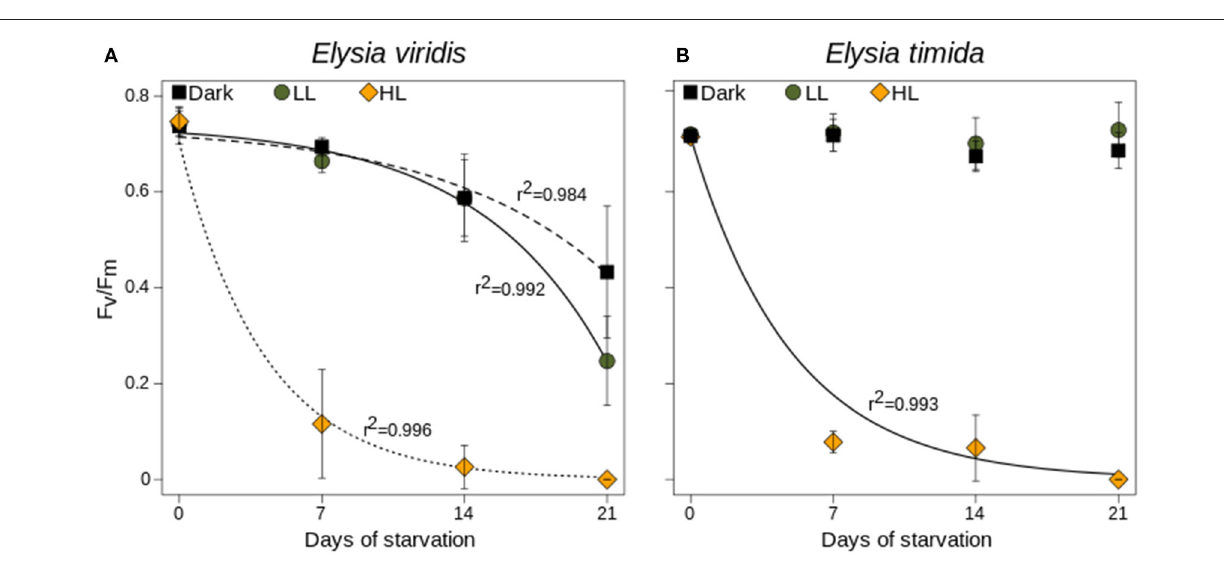
FIGURE 4 | F v /F m measurements of E. viridis (A) and E. timida (B) during starvation and under darkness (black circles), 45 µ mol photons m − 2 s − 1 (green circles) and 250 µ mol photons m − 2 s − 1 (orange circles). All measurements were performed in biological triplicates and error bars show the standard deviation. Lines represent fitted values after the model from Vieira et al.